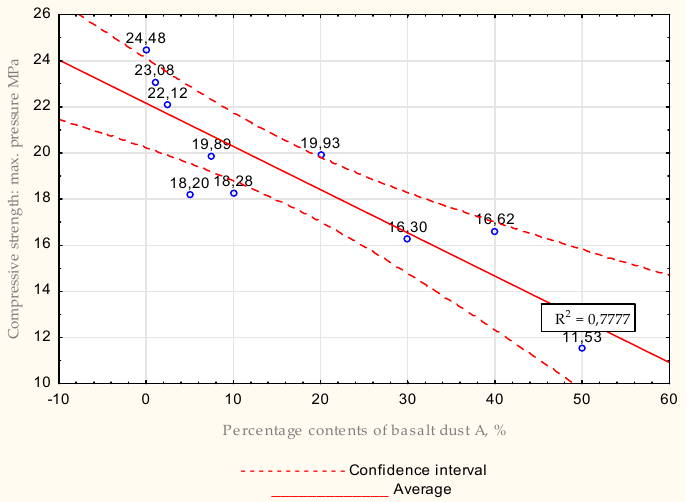
Figure 26. Average values obtained during compressive strength tests for water − mix ratio = 0.7.